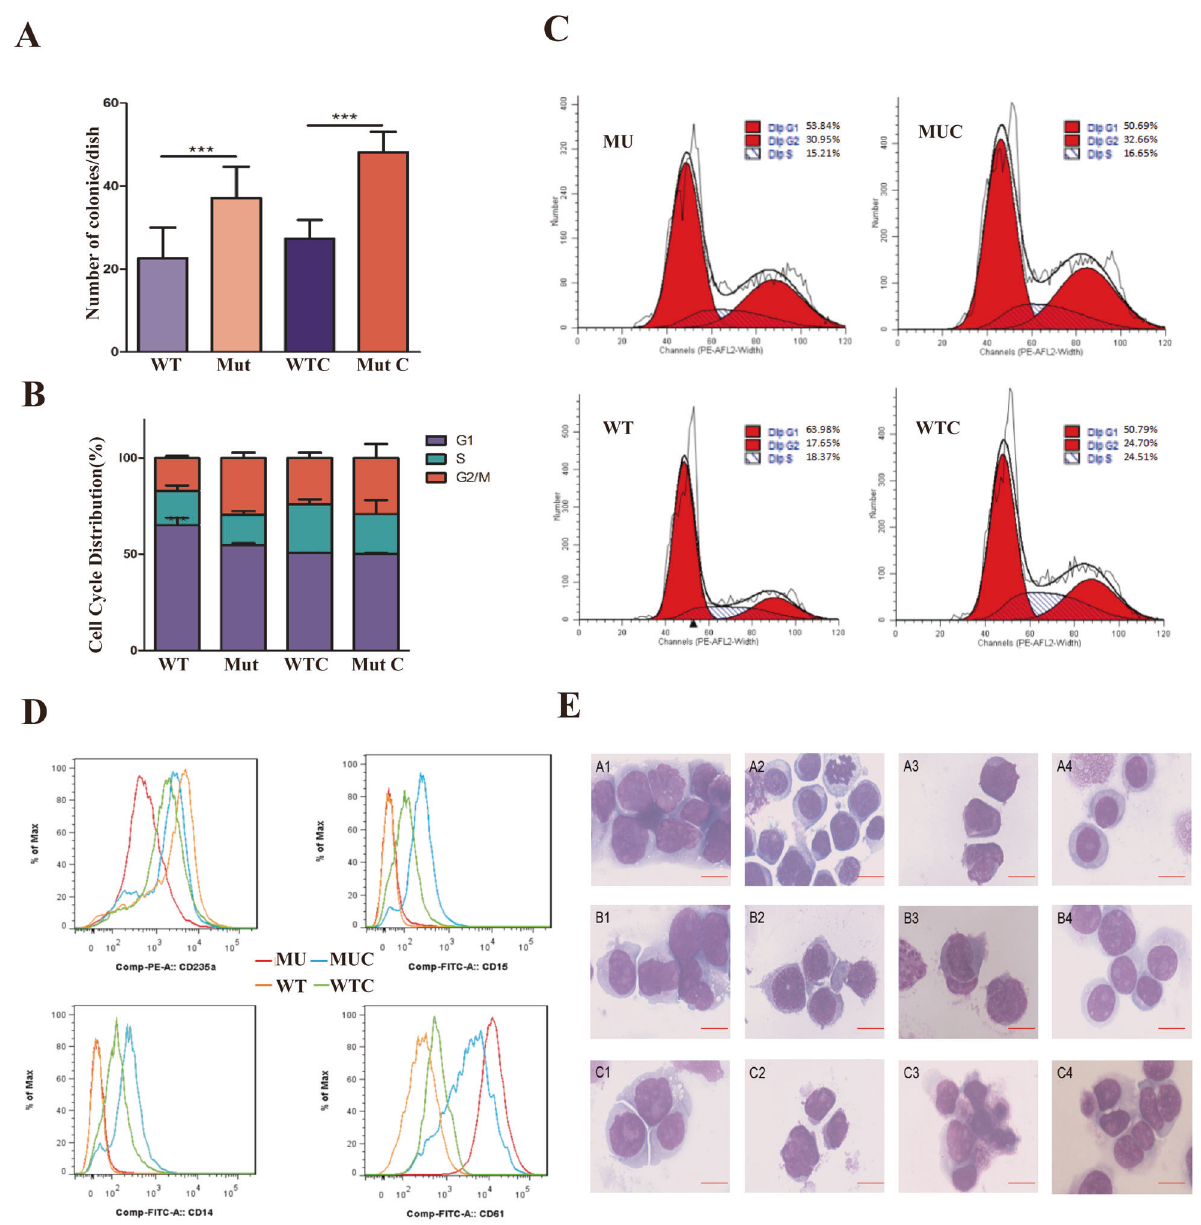
Fig. 5 Functional analysis of CHST15 mutant. A CHST15 mutant promotes HEL cells proliferation with cytokine-independent fashion (colony- forming tests): HEL cells harbouring CHST 15 mutant (1 × 10 5 ) or wild-type CHST15 (1 × 10 5 ) were plated under semisolid condition and colonies were counted 14 d after cultured. Shown are average colonies ± s.e.m; The experiment performed in triplicate. *** p < 0.001. B Analysis of cell cycle distribution: HEL cells with CHST15 mutant (MU) or CHST15 mutation-negative (WT) in the presence (WTC or MUC) or absence of cytokine were cultured in 1640 medium; cells were harvested at day 7 and were analyzed by fl ow cytometry. Compared with WT, HEL cells with CHST15 mutant showed an increased proliferative index (S phase plus G2/M phase%) (*** p < 0.001), and independent of growth factors. C A representative image for cells cycle analysis. D Detection of differentiation markers by fl ow cytometry. demonstrated upregulation of cell surface markers CD14, CD15 and CD61 in HEL cells with CHST15 mutant in the presence of cytokines; whereas there was no effecton CD235a expression. Data are shownas the mean ± s.e.m of three independent experiments. E Morphological changes associated with differentiation of HEL cells were evidenced by Wright-Giemsa staining (100×). Upper panel: A2, A4 showed characteristics of myeloid differentiated in CHST15 mutant with shrunken cell nucleus and decreased the nuclear/cytoplastic ratio (N:C ratio) (A1-WT; A2-MU; A3-WT plus cytokine; A4-MU plus cytokine); Middle panel: B1, B4 represented monocytic differentiation with alleviated nuclear- folded and regular cellular outline in CHST15 mutant cells. (B1-WT; B2-MU; B3-WT plus cytokine; B4-MU plus cytokine); Lower panel: C1, C4 represents megakaryocytic differentiation (C1-WT; C2-MU; C3-WT plus cytokine; C4-MU plus cytokine). mechanism of CHST15 mutation-related MPN may lead to not only In summary, analysis of three families with the same geographical the identi fi cation of novel biomarkers but also the development of origin identi fi ed a mutant locus in CHST15 that is associated with the new therapeutic targets for MPN. development of familial MPN. Further insights into the underlying